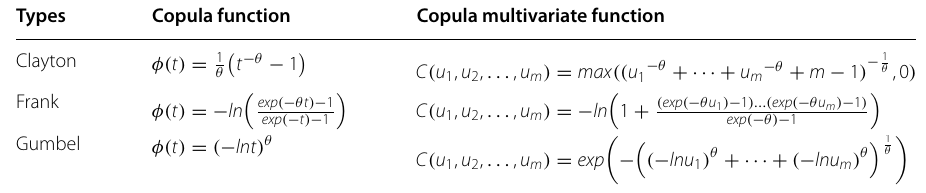
Table 1 The Archimedean copulas Types Copula function Copula multivariate